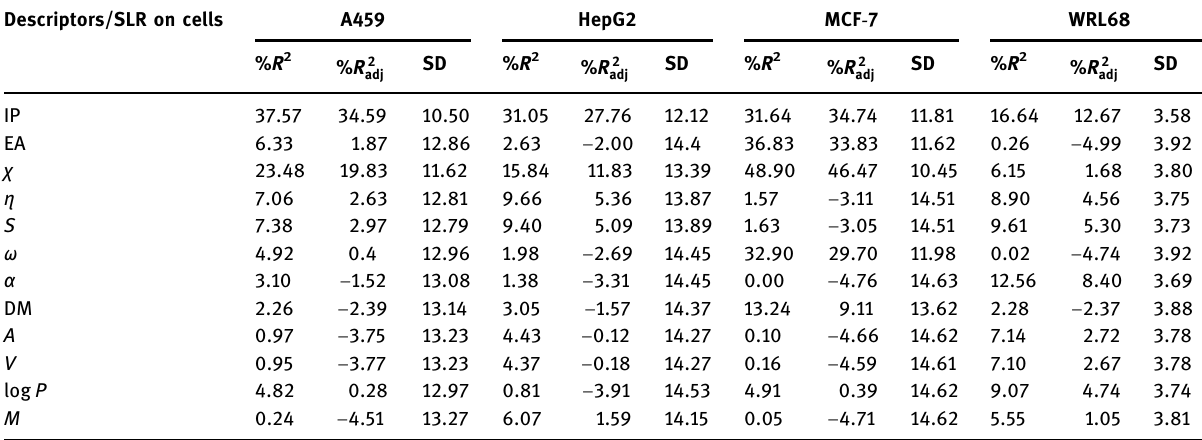
Table 4: Correlation coe ffi cients ( R 2 ) , adjusted correlation coe ffi cients